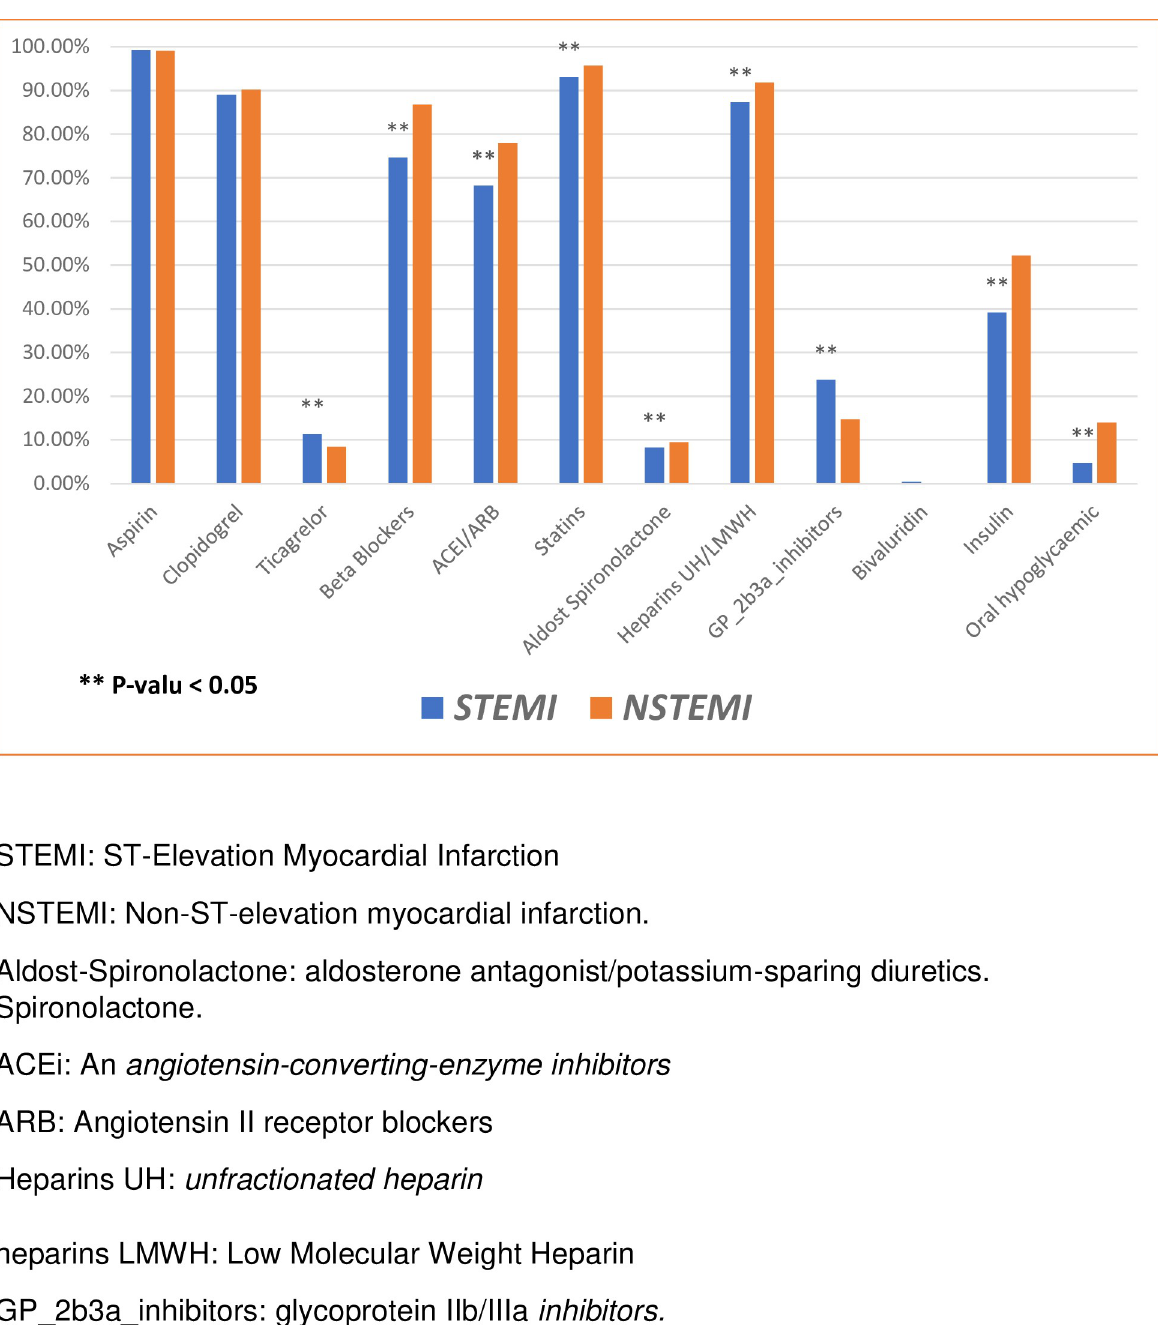
Fig 2. Medications use in the first 24 hrs of hospital admission for patients with acute myocardial infarction. STEMI: ST-elevation myocardial infarction; NSTEMI: non-ST-elevation myocardial infarction.